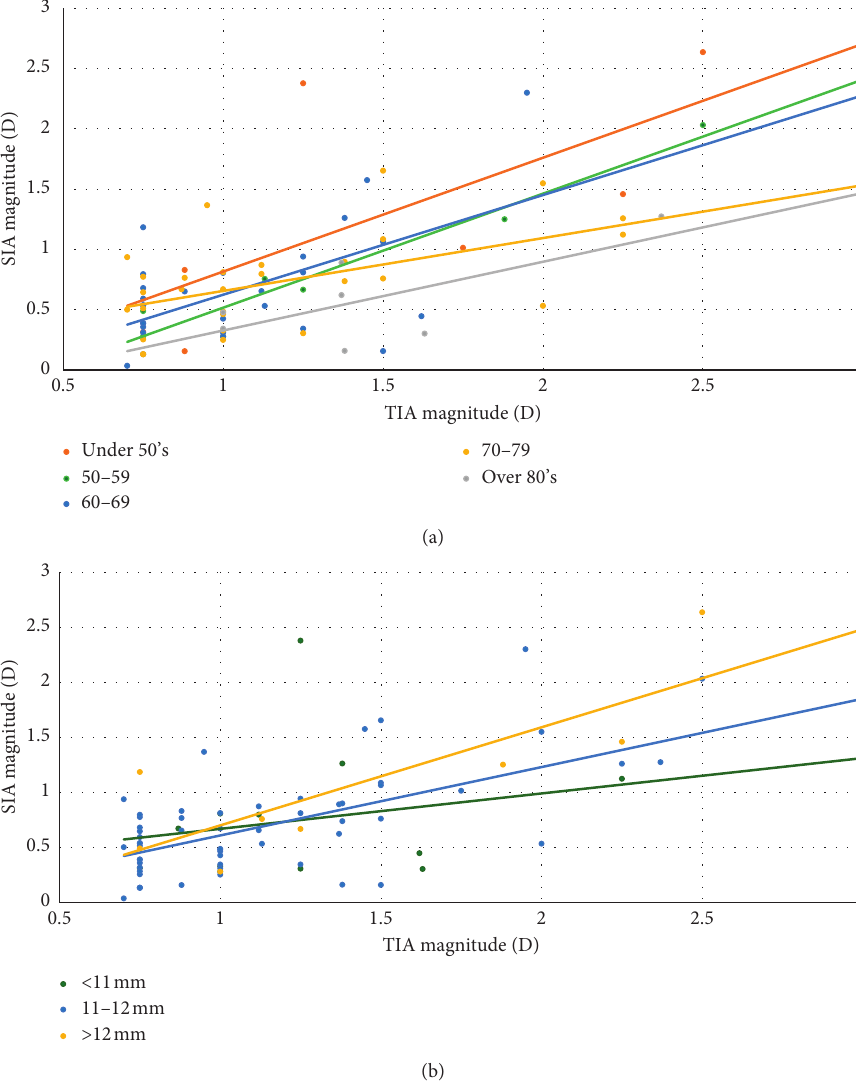
Figure 3: Correlation analysis between the surgically induced astigmatism and target-induced astigmatism in subgroups according to the patient age (a) and the longest white-to-white corneal diameter